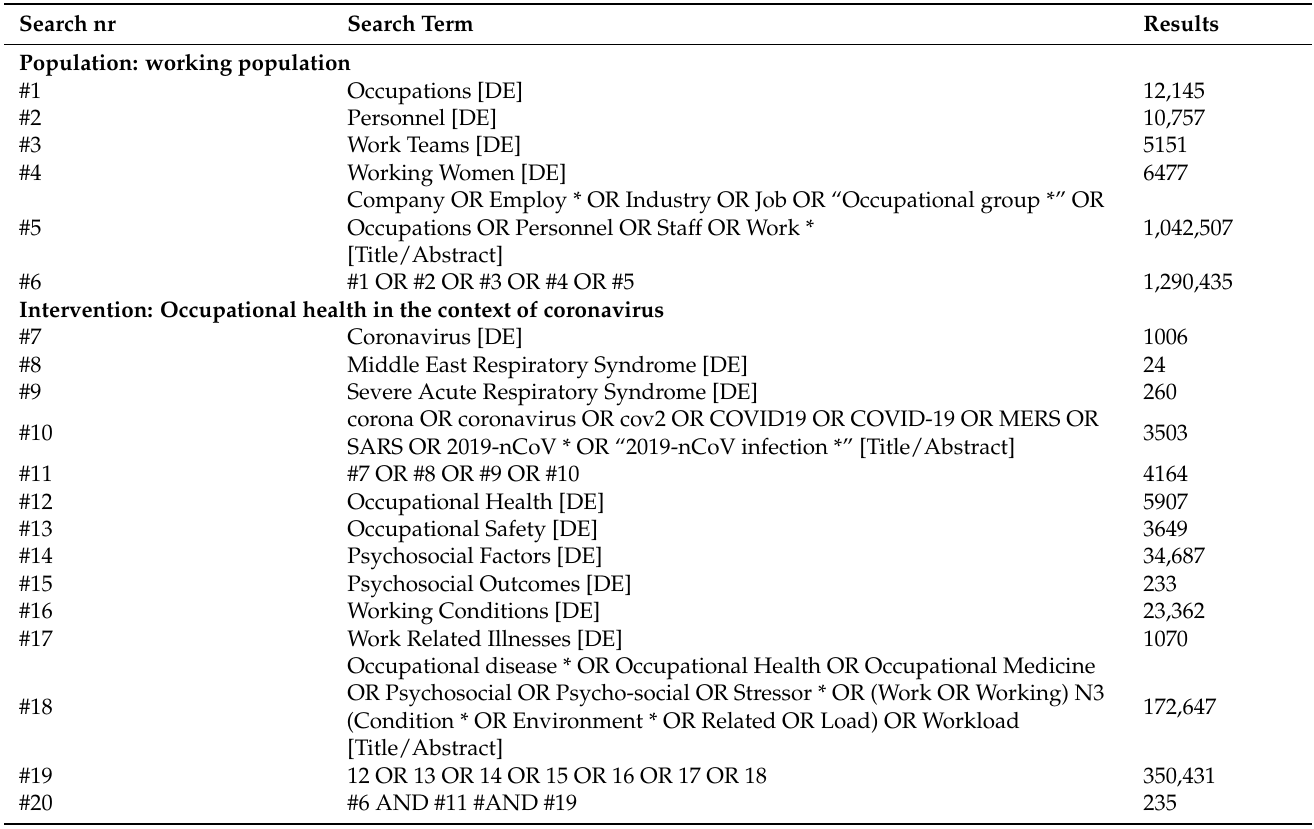
Table A2. Database: PsycInfo ( via Ebsco) Date: 20201005 .